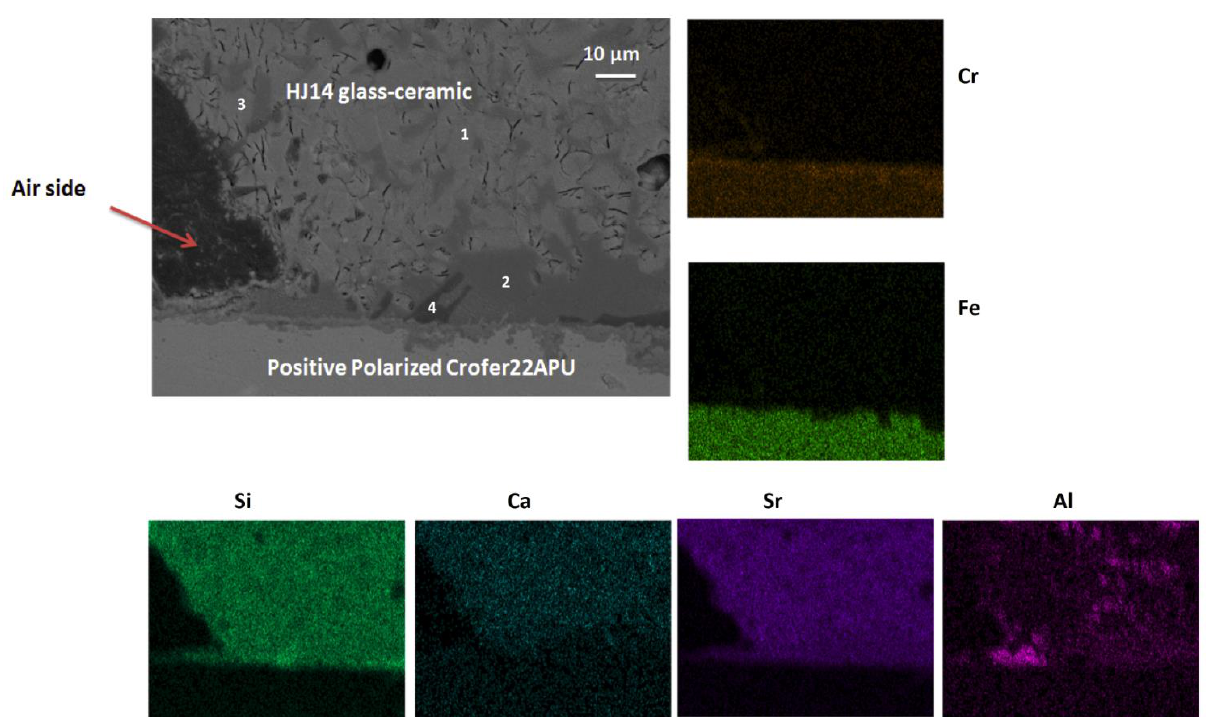
Figure 6. SEM image and EDS mapping of the air side of the positively polarized Crofer22APU/HJ14 glass-ceramic interface.